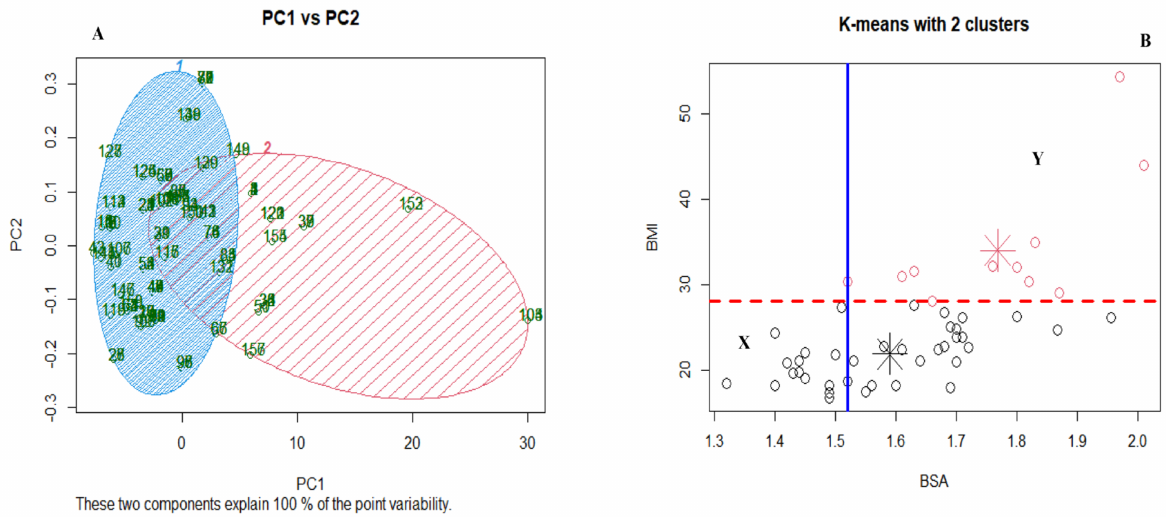
Figure 7. Principal component analysis with BSA and BMI k-means clustering using global severe adverse events as the confusion matrix. Principal Component 1 vs Principal Component 2 ( A ). Clus- tering of the cohort based on adverse events using k-means cluster ( B ). PC1., Principal Component 1; PC2., Principal Component 2; BMI., Body Mass Index; BSA., Body Surface